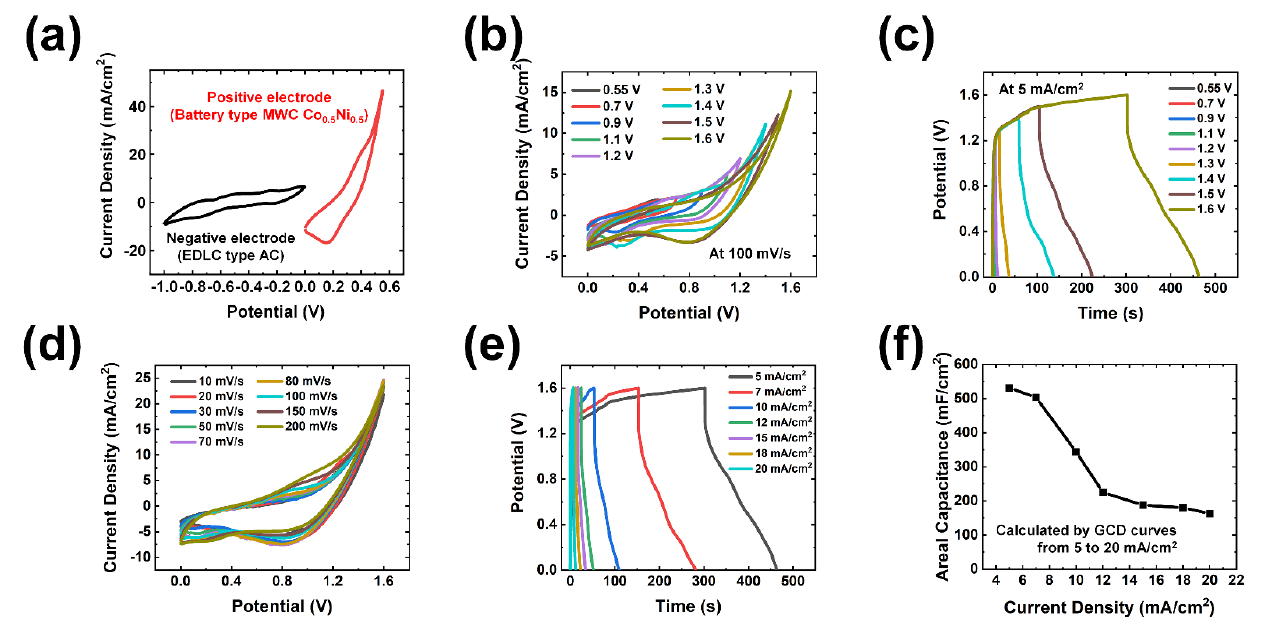
Figure 5. Electrochemical performance of assembled hybrid supercapacitor (HSC). ( a ) CV graphs of EDLC type AC as negative electrode (from −1.0 to 0 V) and battery type MWC Co 0.5 Ni 0.5 as positive electrode (from 0 to 0.55 V). Electrochemical performance under potential windows from 0 – 0.55 to 0 – 1.6 V as indicated in ( b ) CV curves (at 100 mV/s) and ( c ) GCD curves (at 5 mA/cm 2 ). Detailed measurement under extended potential window from 0 to 1.6 V in ( d ) CV graphs (from 10 to 200 mV/s) and ( e ) GCD graphs (from 5 to 20 mA/ cm 2 ). ( f ) Areal capacitance values calculated by G.CD